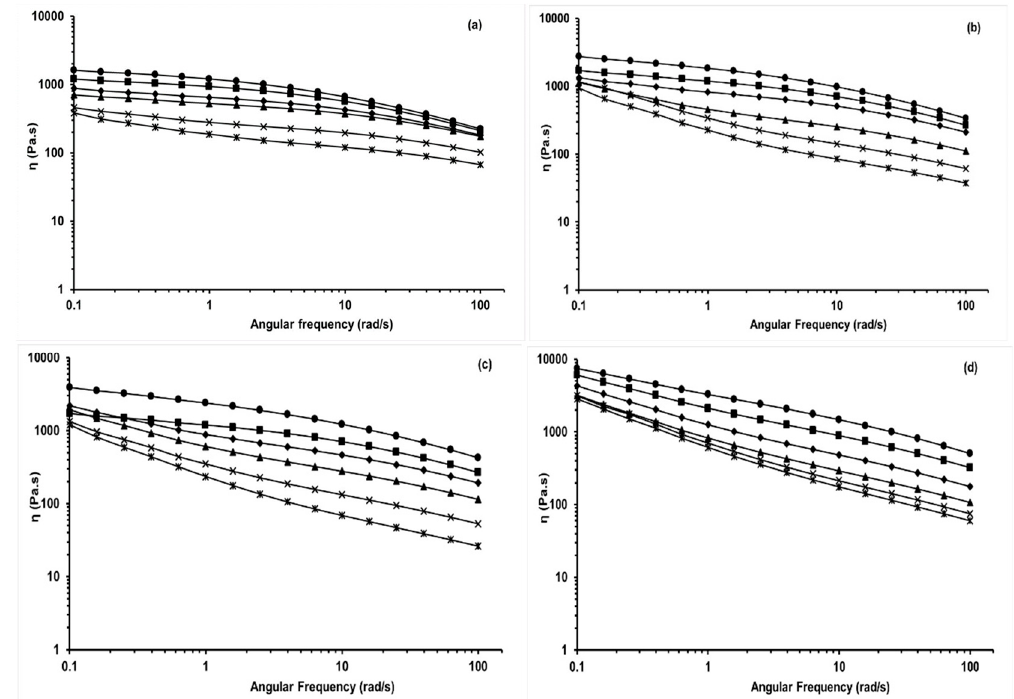
Figure 2. Complex viscosity ( η ) as a function of angular frequency (rad/s) at different temperatures (150–200 °C) for ( a ) polyacrylonitrile (PAN); ( b ) PAN-10%wt BL; ( c ) PAN-20%wt BL; and ( d ) PAN-30%wt BL; ● —150 °C; ■ —160 °C; —170 °C; ▲ —180 °C; x—190 °C; ӿ —200 °C.